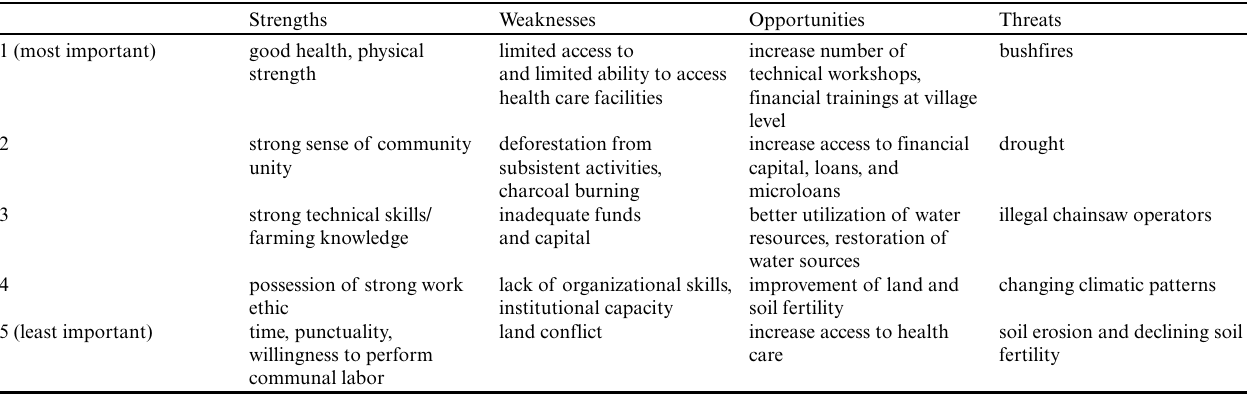
Table 1 . Results from the top 5 strengths, weaknesses, opportunities, and threats (SWOT) factors averaged and ranked in order of perceived importance, where 1 is the most important and 5 is the least important, by 12 community groups living in the Akwapim- Togo Range, Volta Region,